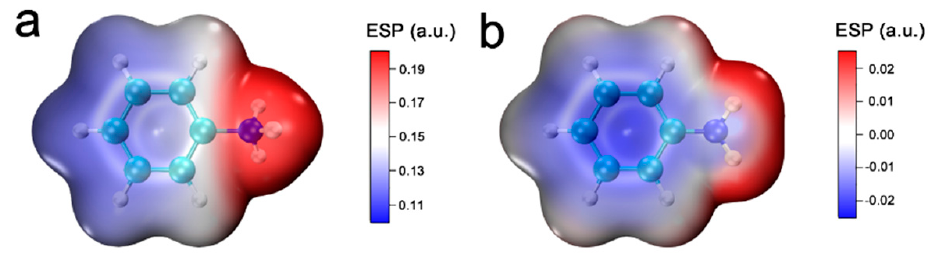
Figure 4. RESP ‐ mapped van der Waals surface. ( a ) ANI + , ( b ) ANIm. The adsorption of ANI + weakened the interlayer interactions of graphite and enlarged its interlayer distance, facilitating the intercalation of other ANI + . However, another intercalation simulation manifested little ANI + intercalating into the interlayer graphite within 10 ns (see Figure S5), as recorded in Video S2. According to previous works, the intercalation of ANI + into graphite is thermodynamically feasible [21]. Consequently, the reason of the unsuccessful intercalation seems unclear. To find the truth, it is necessary to understand the structural characteristics and dynamic behaviors of the ANI + solution in a free state. The following MD simulation of the ANI + solution involved 100 ANI + and 100 Cl − . The solvent-accessible surface area (SASA) of ANI + is shown in Figure 5a. SASA refers to the numbers of H 2 O molecules that could access aniline cations, which can evaluate the dissolution of ANI + in an aqueous solution. The SASA for ANI + was about 210 nm 2 during the whole simulation, indicating the essence of a homogeneous solution. Figure 5b shows that the number of hydrogen bonds formed between ANI + and H 2 O was about 250. These hydrogen bonds remained steady for 10 ns, implying the formation of stable hydrated clusters. Considering the 100 ANI + in the solution, each ANI + formed 2.5 hydrogen bonds with H 2 O. Generally, –NH 3+ in ANI + provides two possible kinds of hydrogen bond structure, one of which forms between an N atom in ANI + and an H atom in H 2 O, and the other is between an H atom in the –NH 3+ of ANI + and an O atom in H 2 O. RDF were calculated to confirm the actual structure of the hydrogen bonds. The black line in Figure 5c with a peak located at r = 0.35 nm indicates the vdW interaction-induced adsorption between N in ANI + and H in H 2 O. However, the red curve exhibits another sharp peak at r = 0.18 nm, probably because of the strong hydrogen bond recorded as N + –H–O. The interpenetrating vdW surface presented in Figure 5d